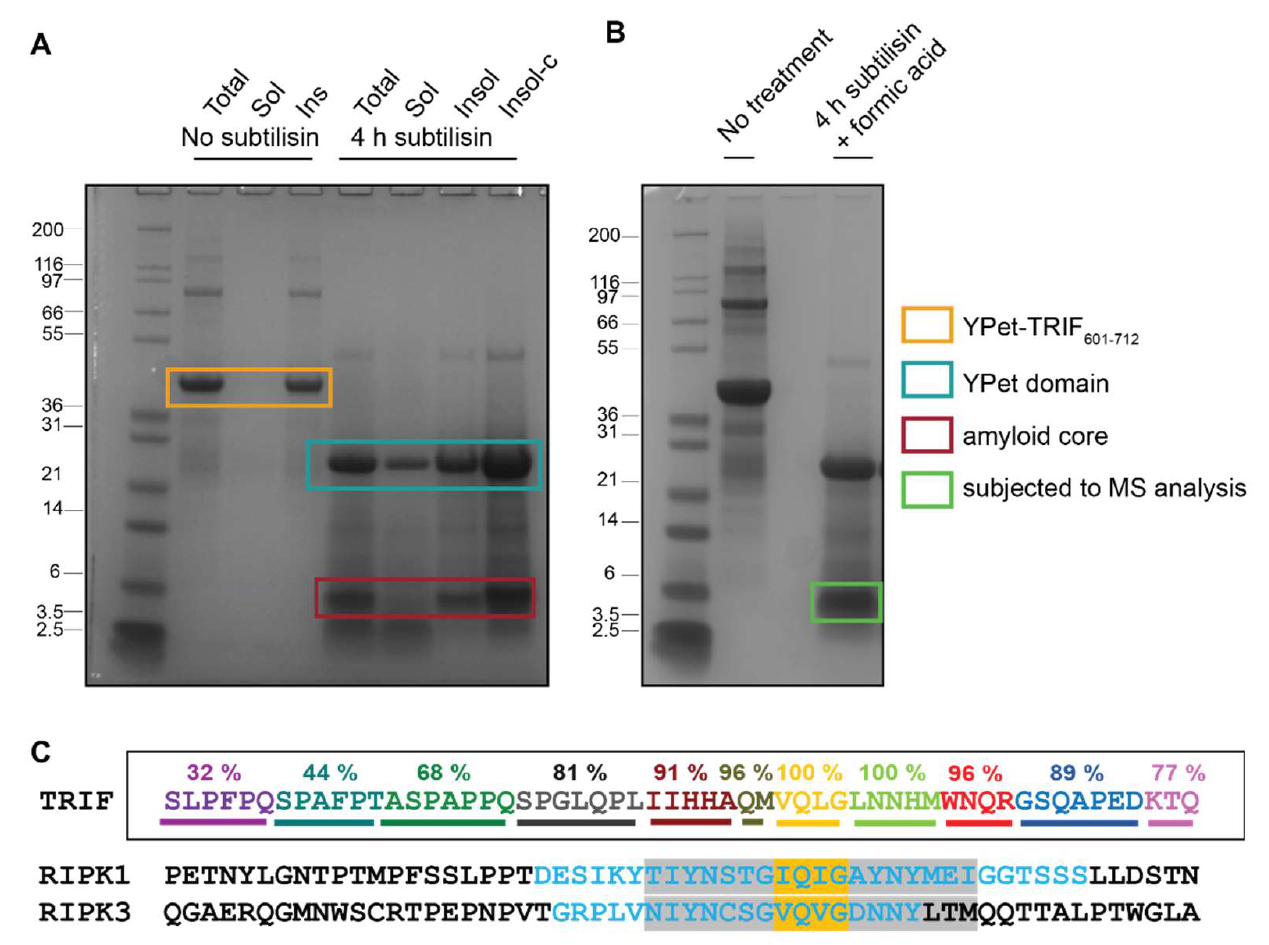
Figure 3. ( A ) SDS PAGE analysis of products of subtilisin digestion of YPet-TRIF 601–712 . Samples are total (Tot), soluble (Sol), insoluble (Insol) or 10X concentrated insoluble (Insol-c). ( B ) Digestion products of YPet-TRIF 601–712 after lyophilisation, resuspension in 90% formic acid and additional lyophilisation, indicating band excised from gel and subjected to mass spectrometry. ( C ) The sequences of the RHIM-containing regions of human TRIF, RIPK1 and RIPK3 aligned by the core tetrad, coloured yellow. % Prevalence of detected TRIF peptides indicated above sequence. All sequences identified by mass spectrometry available in SI Figure S2. Regions within RIPK1 and RIPK3 previously identified as important for amyloid interactions [15] and functional RHIM-dependent signalling [13] indicated in blue and grey, respectively.